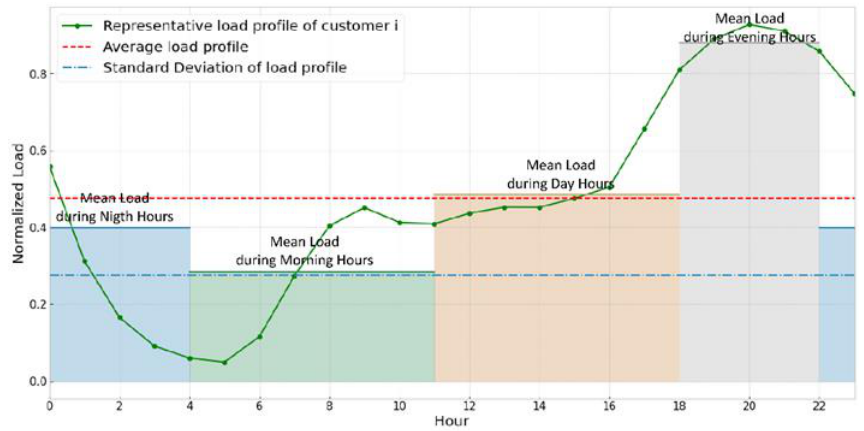
Figure 2. The example of normalized load profile and features of a residential customer. Six features, which are defined in Equations (3)–(5), extracted from the normalized load profiles of all customers. Therefore, the daily load profile of customer i can be defined by six features in Equation (6). Six features are utilized to group residential customers into K clusters using GMM: